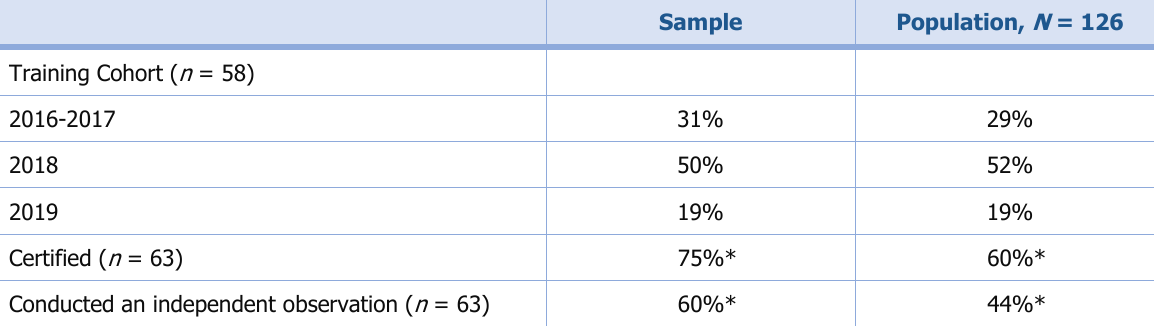
Table 2. Sample and Population by Training Cohort, Certification Status, and Observation